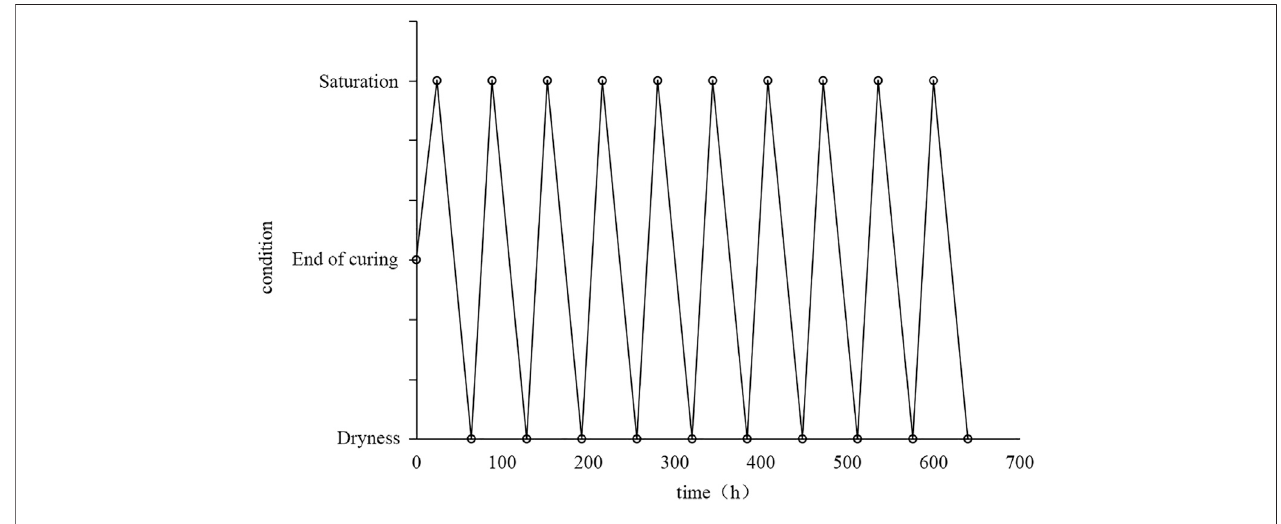
FIGURE 3 | Wet – dry cycling process.